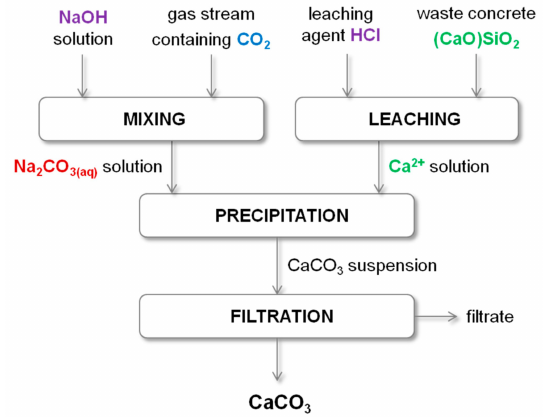
Figure 5. Diagram of the CaCO 3 precipitation process using waste concrete and CO 2 from flue